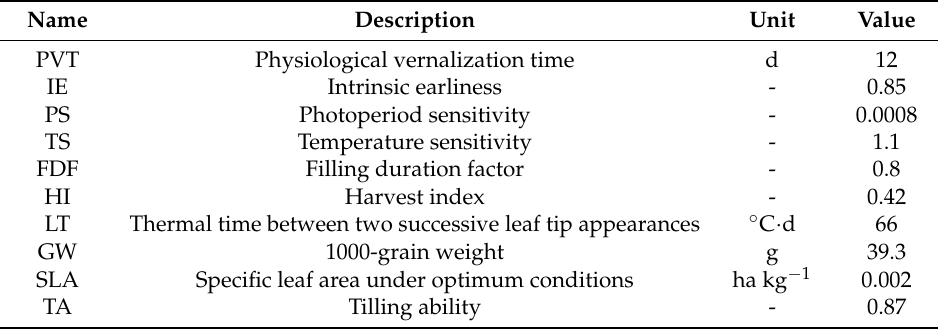
Table 1. Variety parameters adopted by the WheatGrow model in this study.